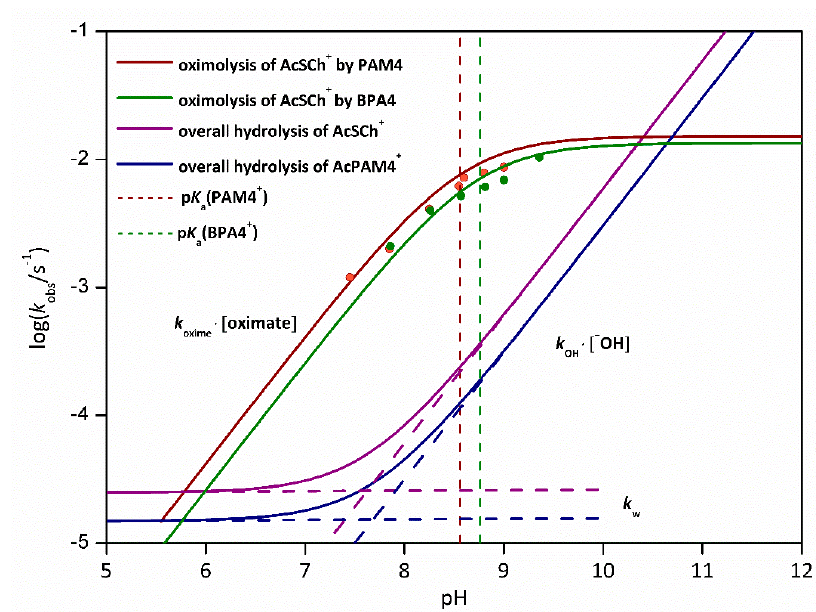
Figure 2. The pH-profiles of the total observed pseudo-first-order rate constants for the oximolysis of the AcSCh + by PAM4 and BPA4 (reaction 1; c (AcSCh + ) = 4 mM) and the neutral and HO − -induced hydrolysis of the AcSCh + (reaction 3) and AcPAM4 + (reaction 2), respectively, at 25 °C.